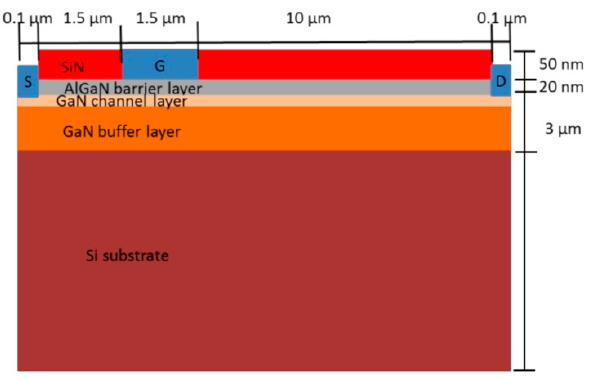
Figure 1. Schematic of a conventional AlGaN/GaN HEMT with an undoped AlGaN/GaN barrier layer, a substrate, a passivation layer, and metal contacts. The AlGaN layer aids in the polarization of the GaN region, which causes an oversupply of free dynamic electrons in the GaN layer. Reprinted with permission from ref. [42]. Copyright 2021 MDPI.